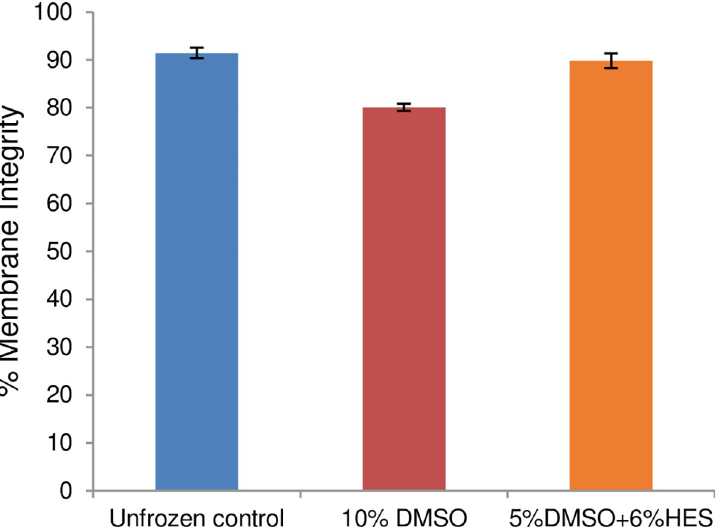
Fig 5. Cryopreservation of astrocytes in suspension. Comparison of membrane integrity of unfrozen astrocytes in suspension and those cooled at 1˚C/min to –40˚C in the presence of 10% DMSO vs . 5% DMSO and 6% HES, plunged into liquid nitrogen, and rapidly thawed. Data are shown as mean ± SEM from two independent experiments using four samples for each